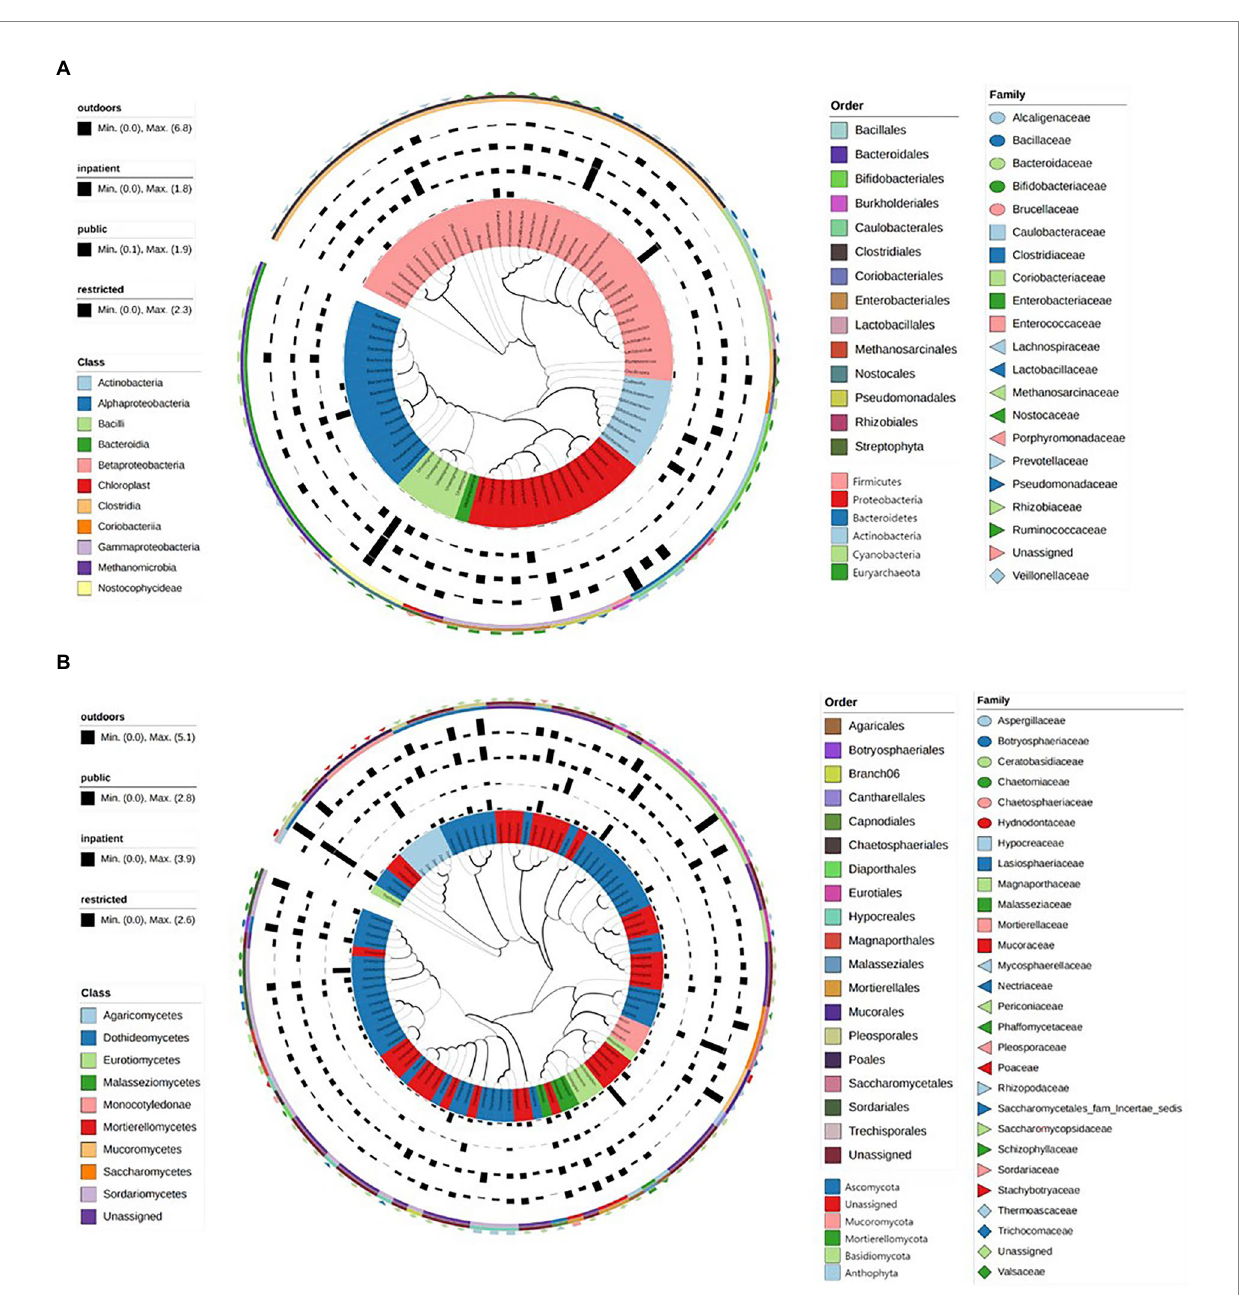
FIGURE. 3 The maximum likelihood trees showed the evolutionary relationship and branching structure of the microbiota based on 16S (A) and ITS (B)